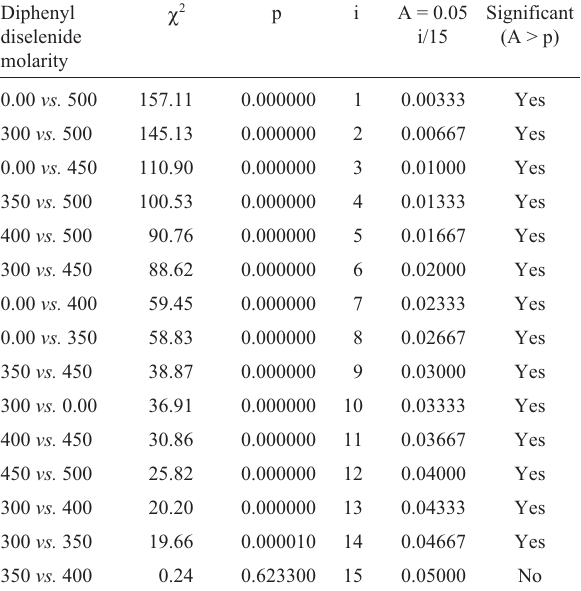
Table 1 - Pairwise chi-squared ( χ 2 ) comparisons of the D. melanogaster egg to pupae developmental rate for flies fed on banana-agar medium sup- plemented with different molarities ( μ mol/kg of medium) of diphenyl diselenide dissolved in dimethyl sulfoxide (DMSO). The comparisons use the Benjamini and Hochberg false discovery rate method and are ranked